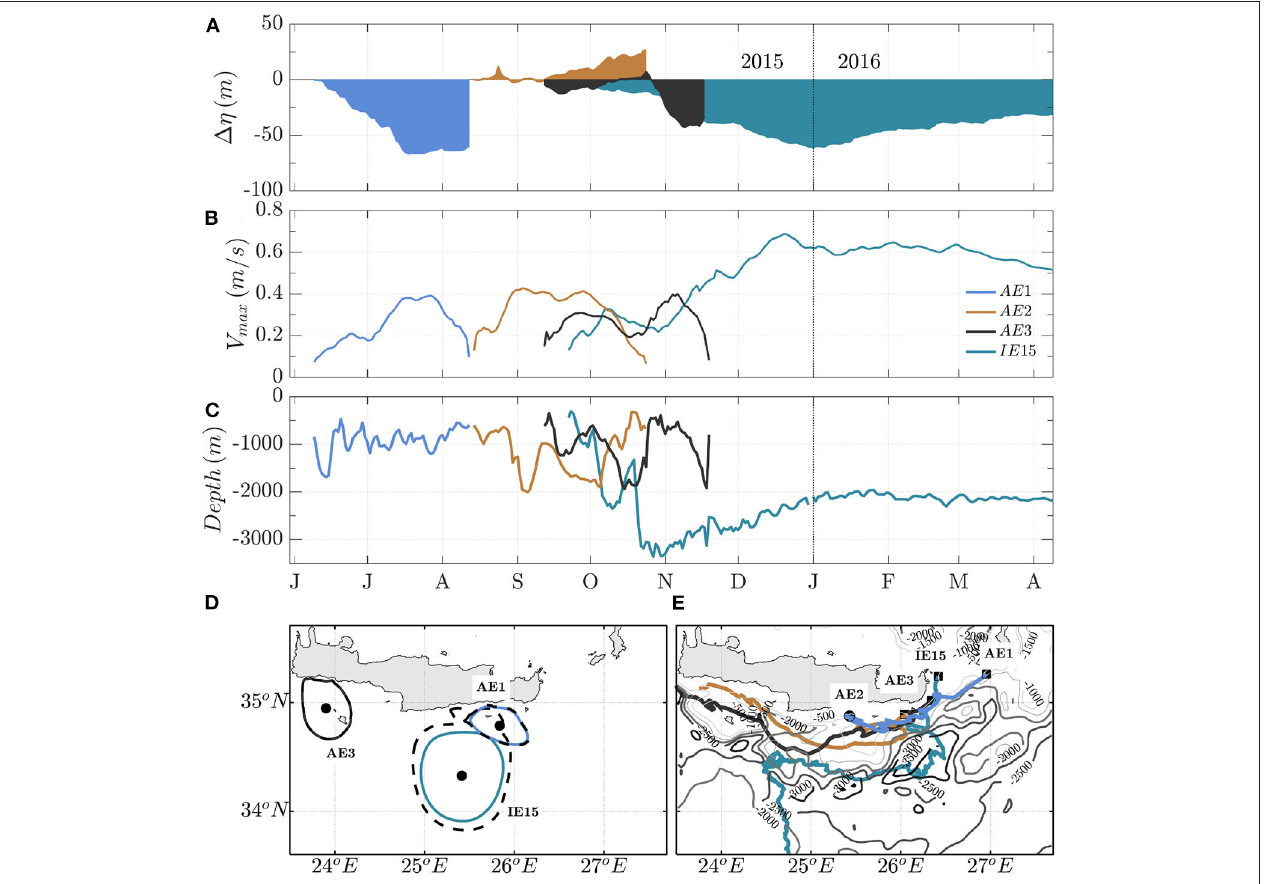
FIGURE 10 | Comparison between the temporal evolution of the anticyclones AE1, AE2, AE3, and M_IE15. The isopycnal displacements after generation 1η ( m ), associated with the wind stress curl h∇ × τ i extracted above the eddies (in an area of 30 km from the eddy center) are illustrated in (A) . The temporal evolution of the eddy characteristic velocities V max and the mean depth along the eddy trajectories are shown in (B,C) for the different anticyclones. The eddy contours and trajectories of the different anticyclones are shown in (D) and (E) . The background map shown in (E) corresponds to the CROCO model bathymetry.